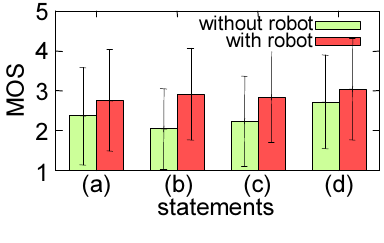
Figure 15. Evaluations for Robot’s